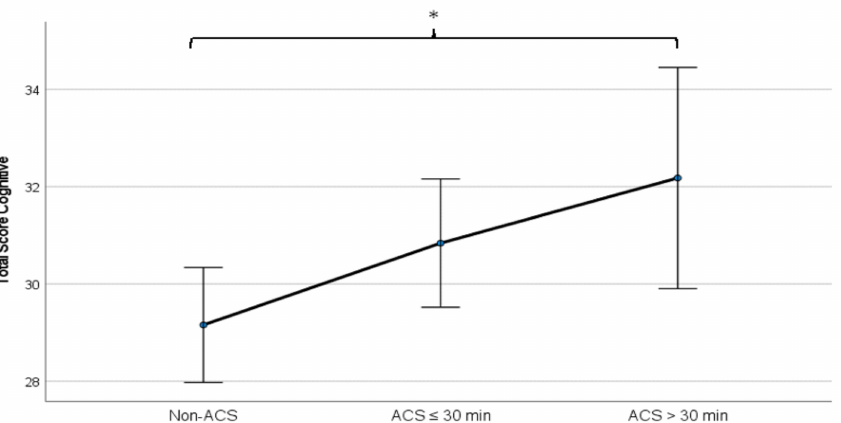
Figure 1. The mean differences in total cognitive score by categories of ACS. Non-ACS—no active